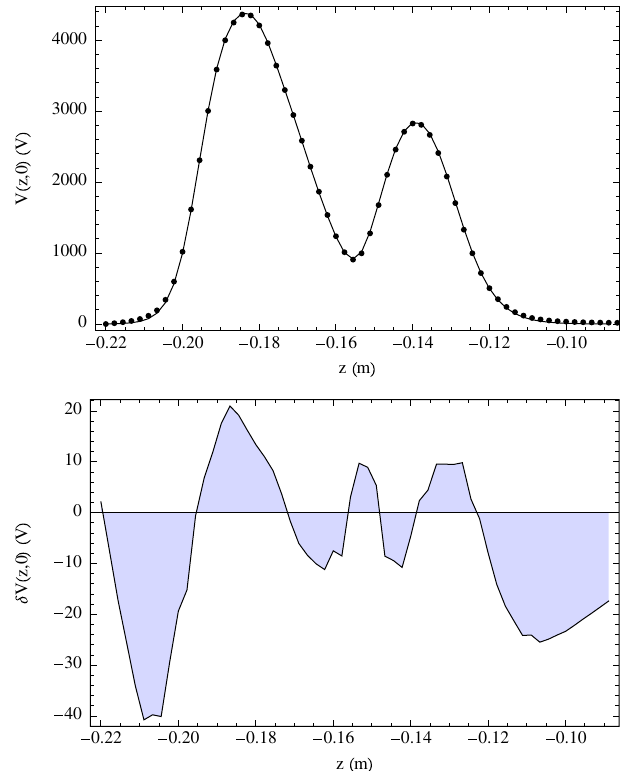
FIG. 6. The line represents the potential on the border used to calculate the potential on the axis and the dots are the numerical solution achieved with COMSOL MULTIPHYSICS (top). The differ- ence between the two previous curves is shown in the bottom ¼ 4513 V , V ¼ 4836 V , V ¼ 3112 V , V ¼ image. Here ( V 1 2 3 4 ¼ 3941 V 1642 V , V z